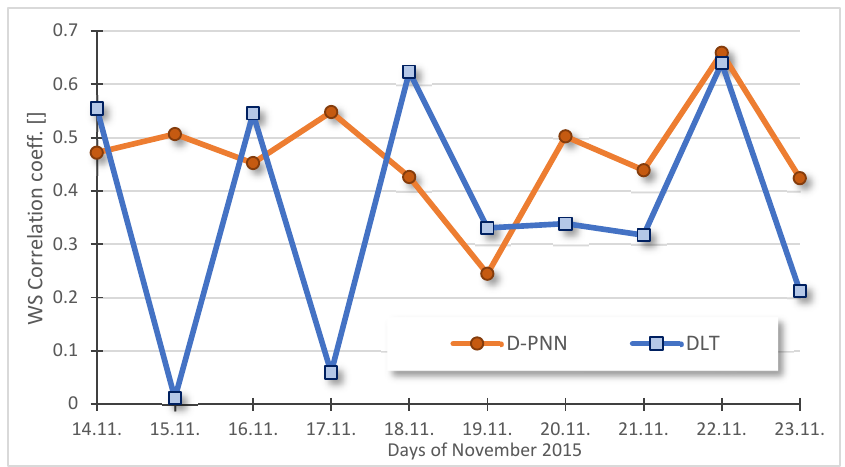
Figure 11. 10-day wind-speed avg. day prediction correlat. determination coeff.: DNN = 0.467, DLT = 0.363 [].